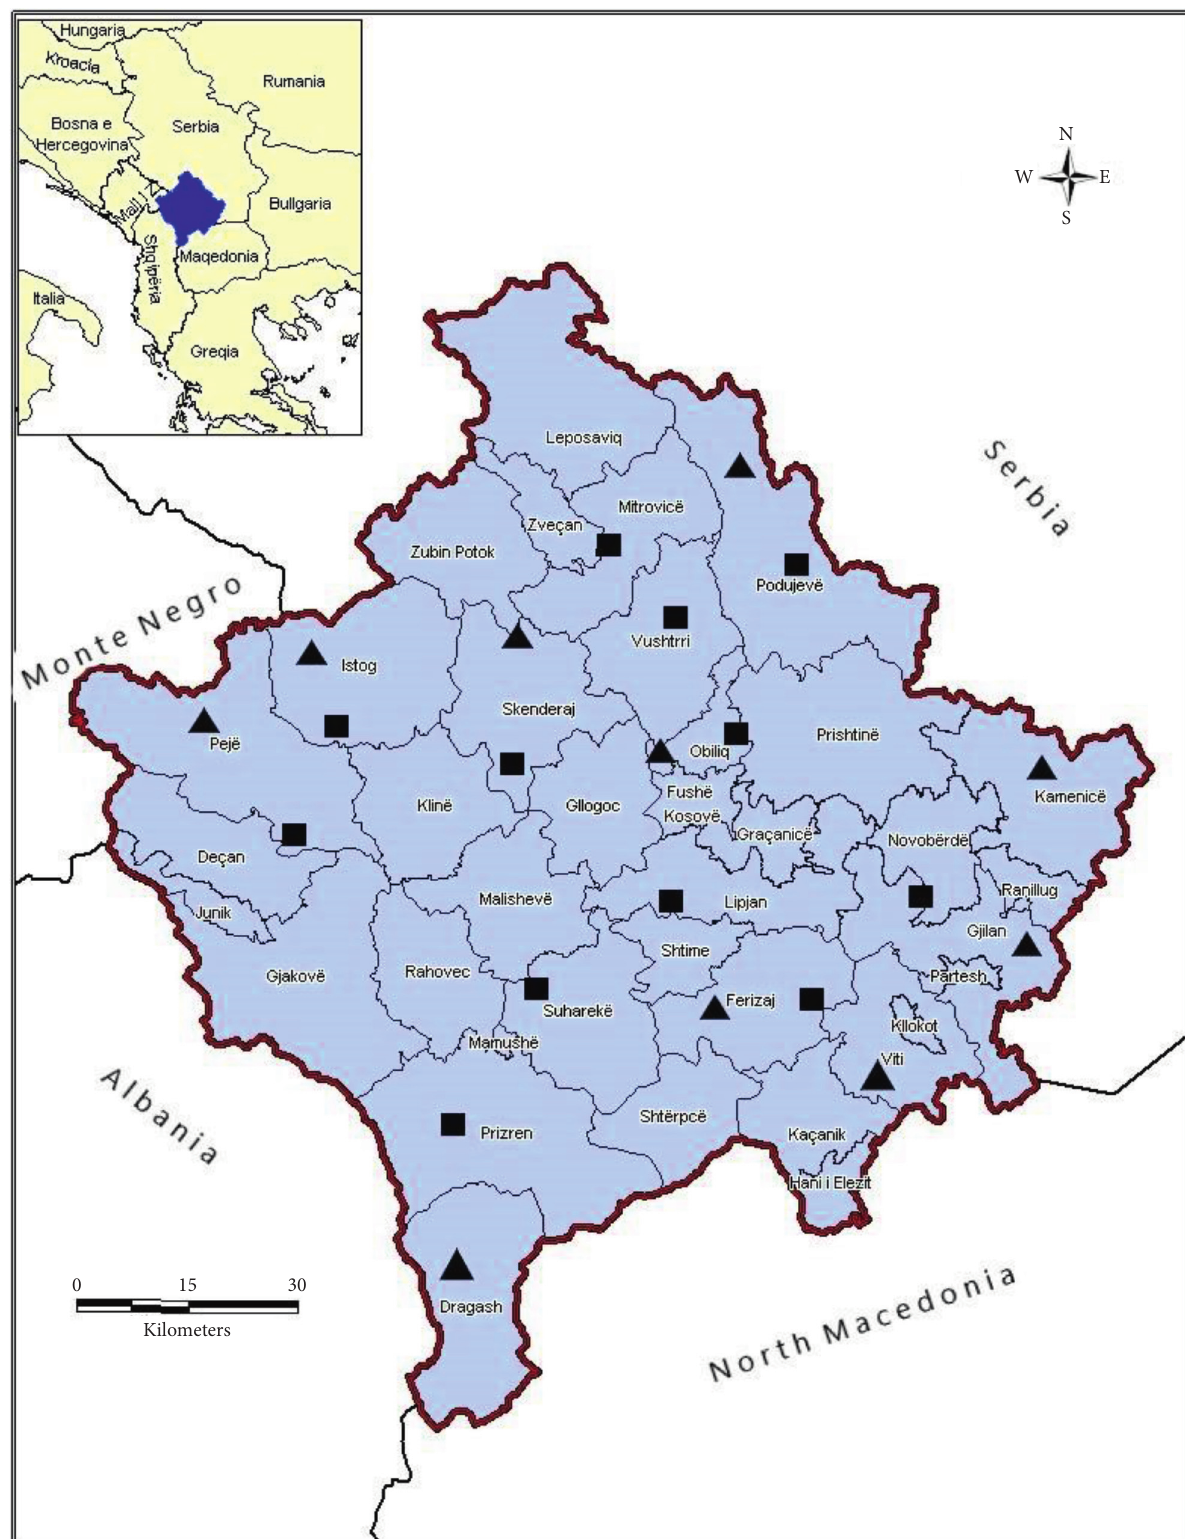
Figure 1: Map showing the location of sampling egg site in